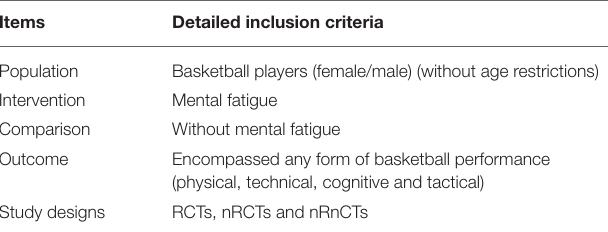
TABLE 1 | Inclusion criteria according to the PICOS